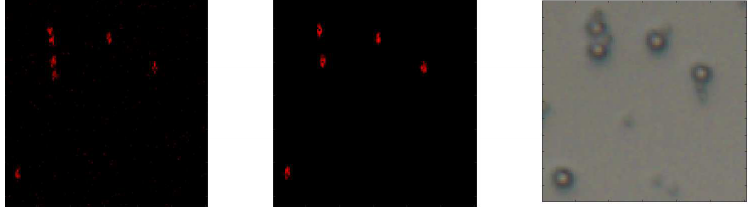
Figure 7. Imaging of the cross-section with 4.5 µ m microspheres only: ( Left ) SOCT image of the cross-section obtained by short-time Fourier transform method; ( Middle ) SOCT image of the cross-section obtained by the proposed method; and ( Right ) cross-sectional view of the area under investigation. SOCT images are normalized and displayed in logarithmic scale. In the microscope image, there are small air bubbles that are not in the imaging XZ plane and they do not contribute our SOCT